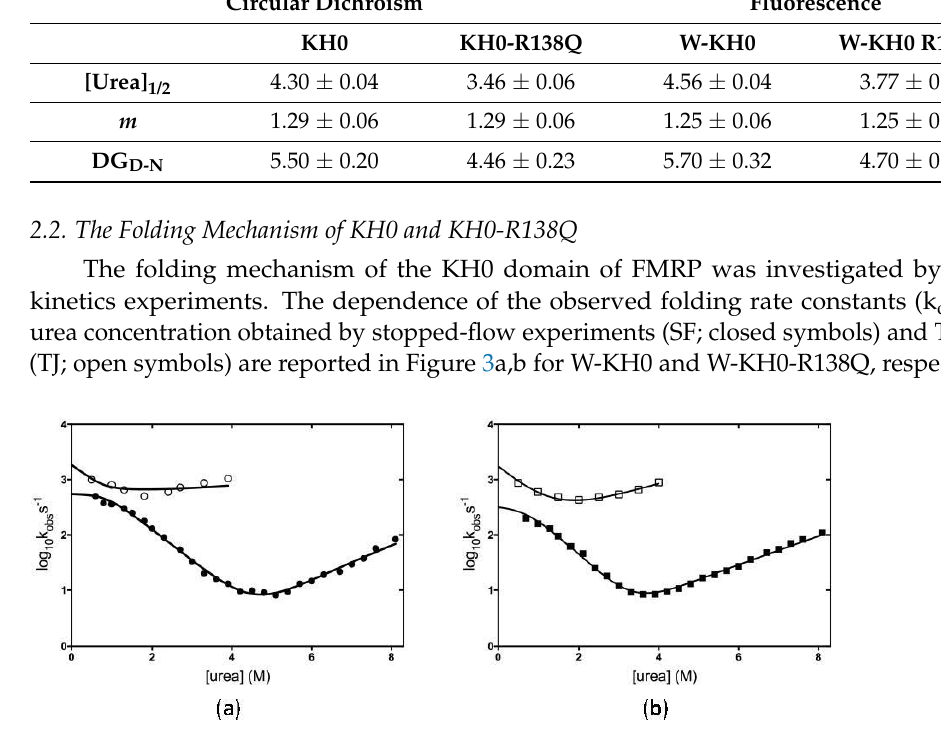
Table 1. Urea-induced thermodynamic parameters obtained by fluorescence and circular dichroism equilibrium experiments. The m parameter was shared between the data sets of the non-fluorescent variants in the CD-monitored denaturations, between the fluorescent variants in the fluorescence- monitored denaturations and between the data sets of the fluorescent variants in the fluorescence- monitored denaturations. [Urea] 1/2 in M; m in kcal mol − 1 M − 1 ; ∆ G D-N in kcal mol − 1 ).